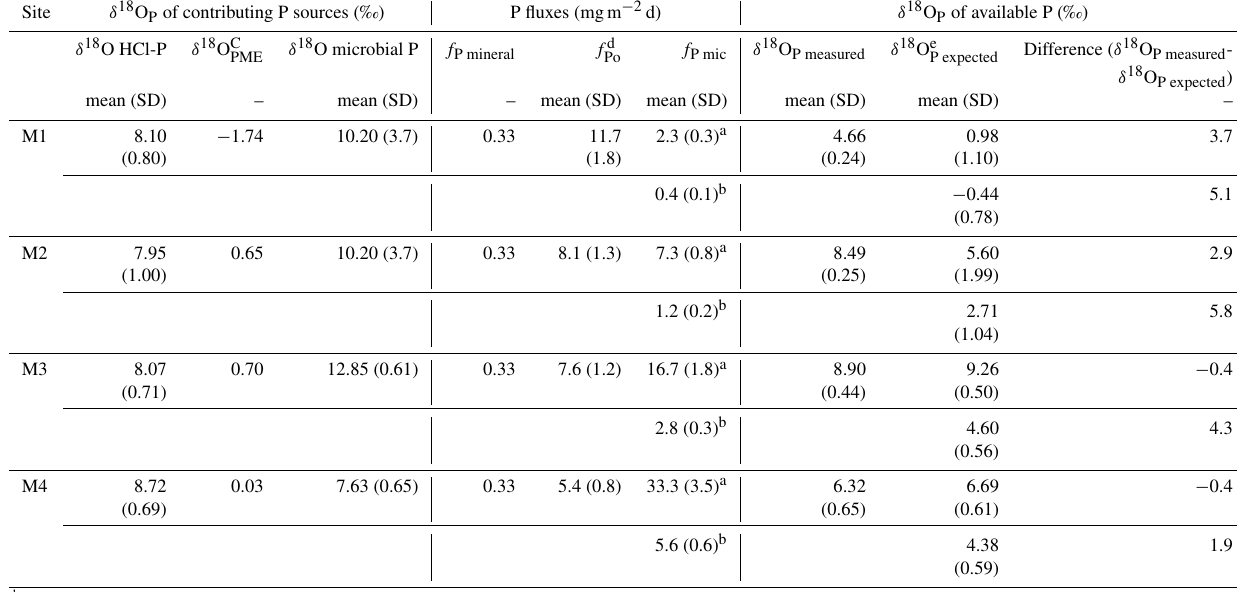
Table 3. Box model estimation of phosphorus fluxes from the mineral, microbial and organic P (Po) pools to the available P.